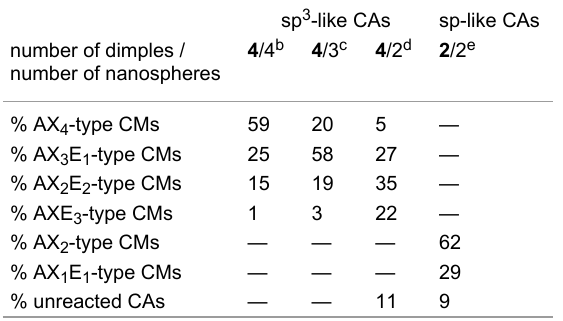
Table 1: Compositions of the batches a resulting from mixing the CAs with 100 nm nanospheres. sp 3 -like CAs sp-like